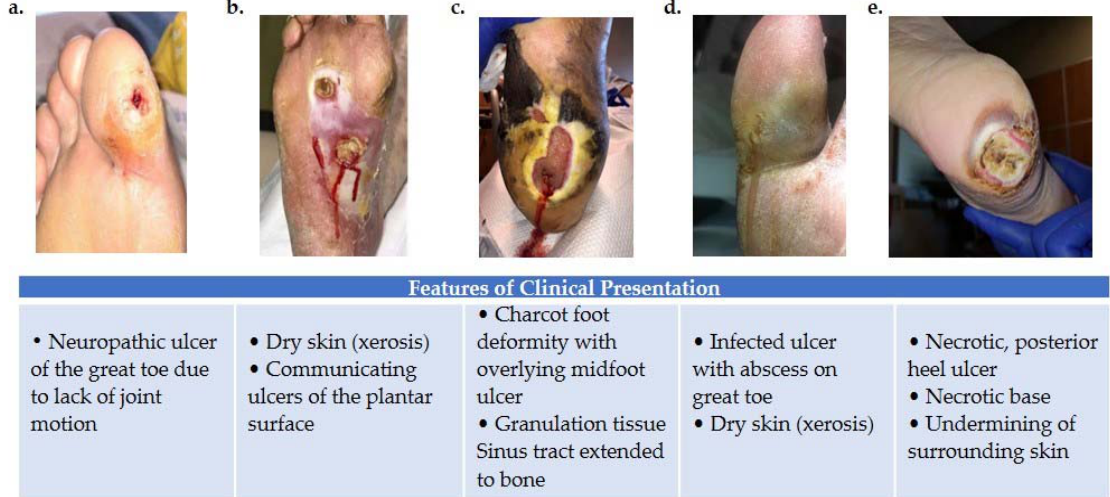
Figure 1. Variations in foot wound location, presentation, and severity as illustrated by images ( a – e ). ( a ) Patient presenting with neuropathic ulcer under the proximal interphalangeal joint of the hallux. The ulcer is related to lack of joint motion at the first metatarsophalangeal joint. ( b ) Patient presenting with an infected ulcer following the flexor tendons of the foot. Notice a blow lesion at the plantar arch. Dry skin (xerosis) is a sign of autonomic neuropathy. ( c ) Patient presenting with Charcot foot deformity and overlying midfoot ulcer. Macerated skin around the edges of the ulcer and a sinus tract that extends to the bone is also seen. ( d ) Patient with an infected ulcer with abscess on the great toe and xerosis suggesting autonomic neuropathy. ( e ) Patient with a posterior heel ulcer containing a necrotic base and undermining of surrounding skin.